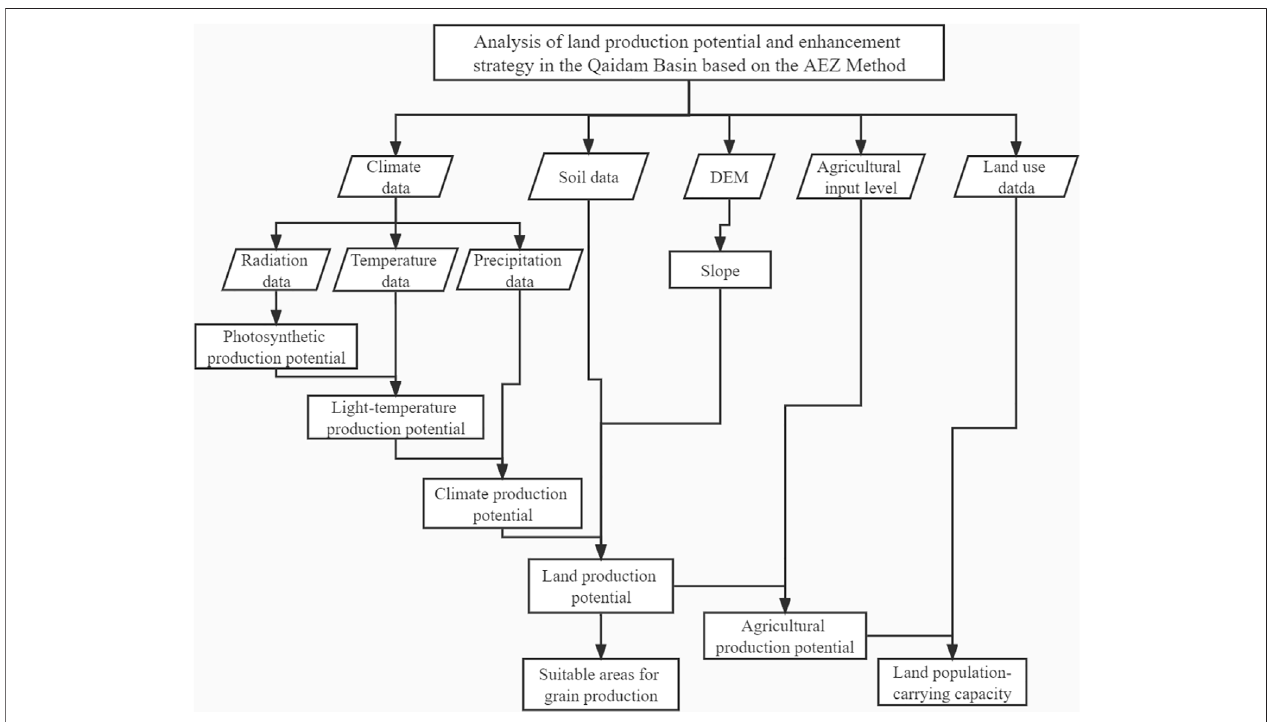
FIGURE 2 | Technical